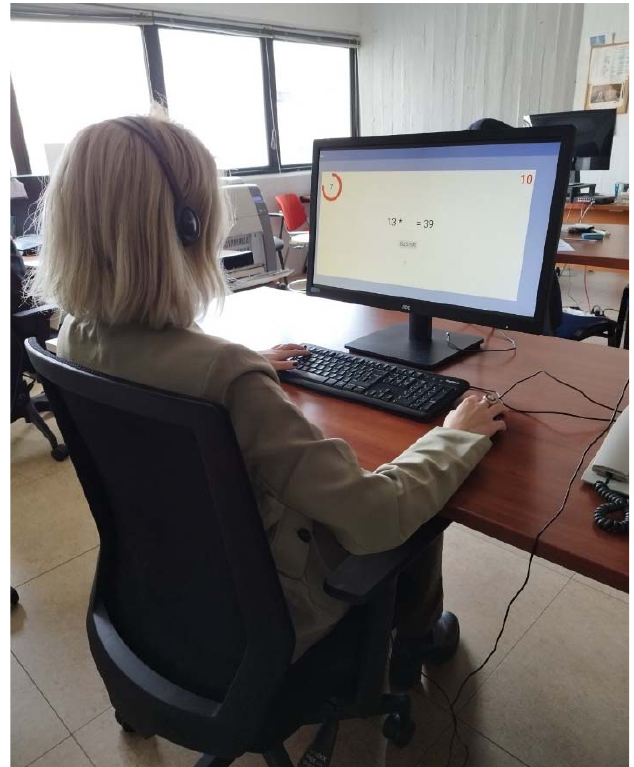
Figure 4. The experimental setup. The subject is seated in an office environment and performs stress‐inducing tasks on the computer using the computer’s custom mouse and computer keyboard.